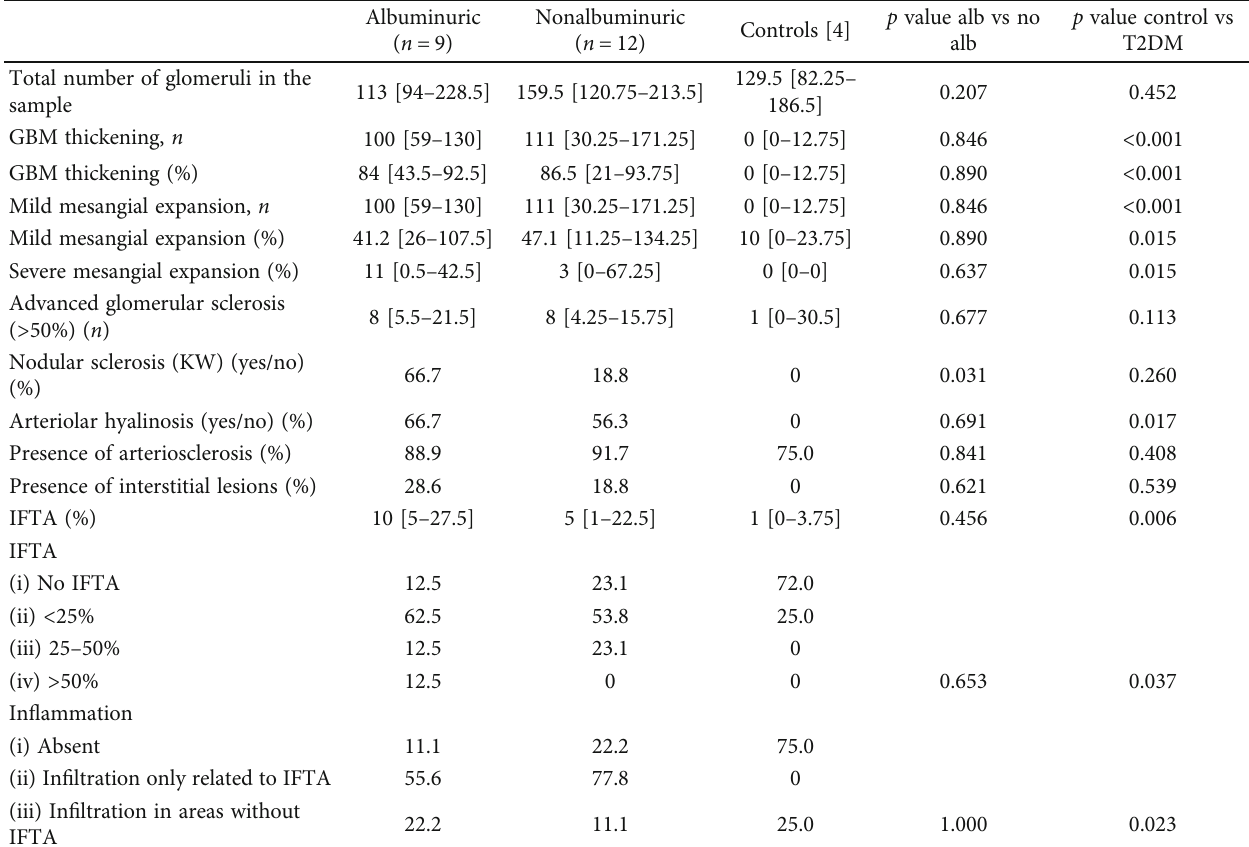
Table 2: Renal histologic fi ndings in necropsies of T2DM (albuminuric and nonalbuminuric) patients and nondiabetic